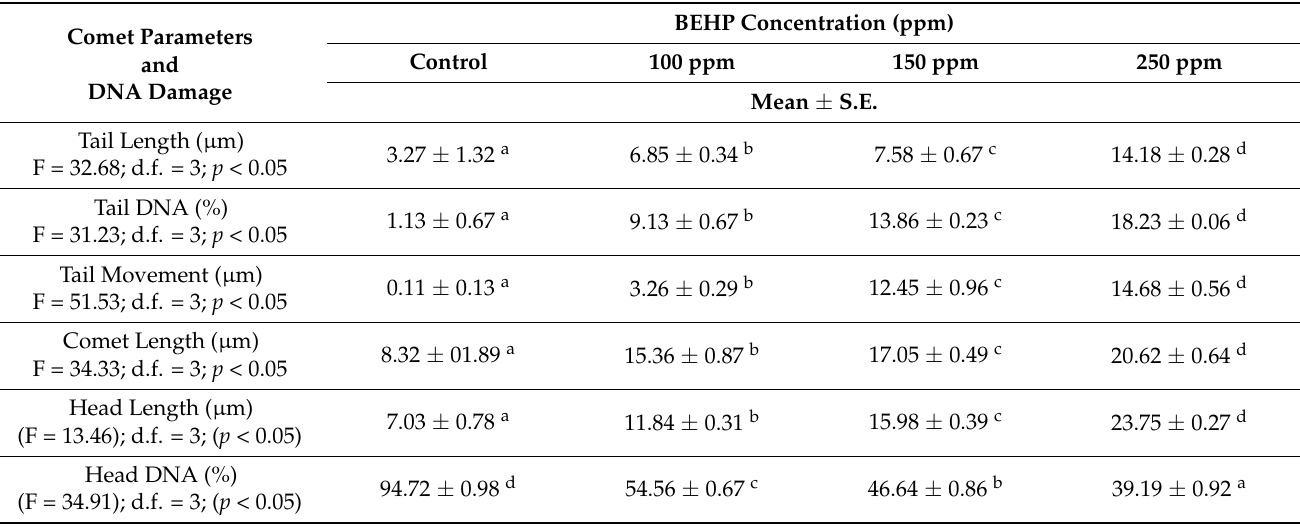
Table 5. Comet parameters and DNA damage of C. quinquefasciatus larvae at different concentrations of